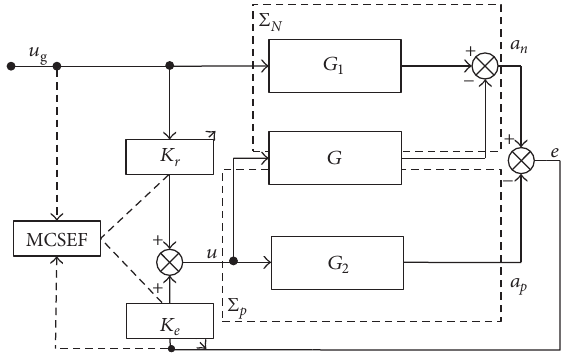
Figure 6: MLSC-MCSEF controlled RTDS